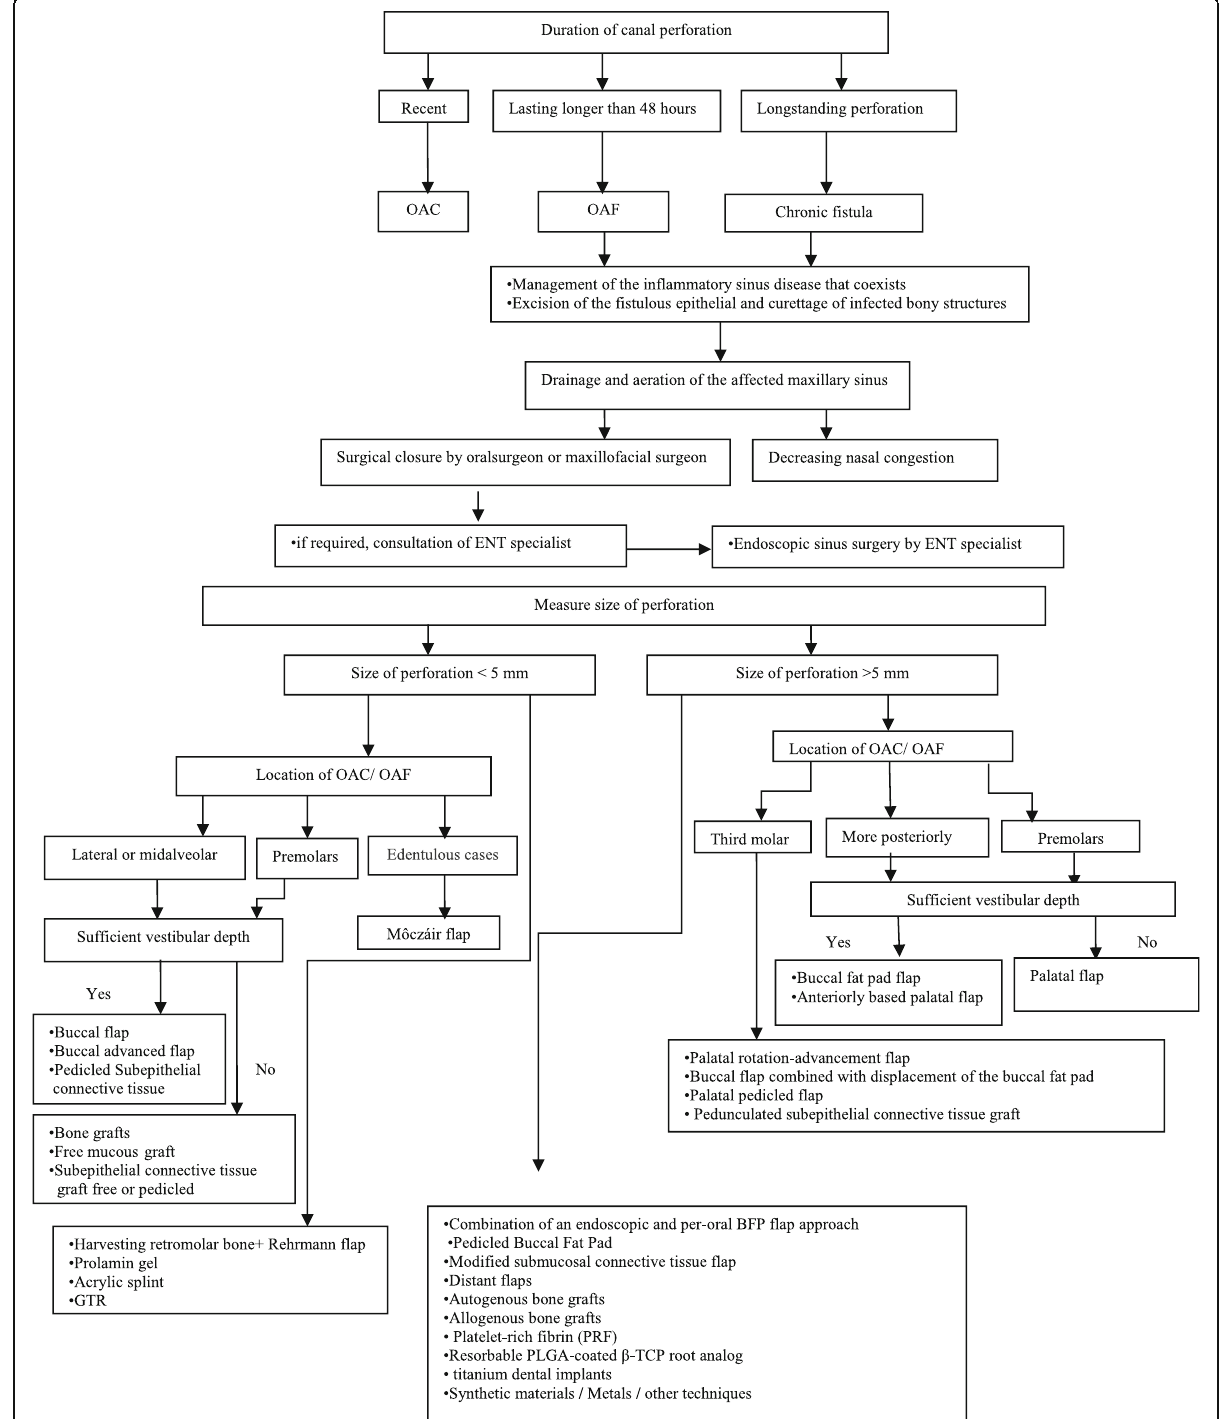
Fig. 8 Decision tree for the closure of OAC and OAF including suggested treatment options based upon size, location, and time of diagnosis of OAC and